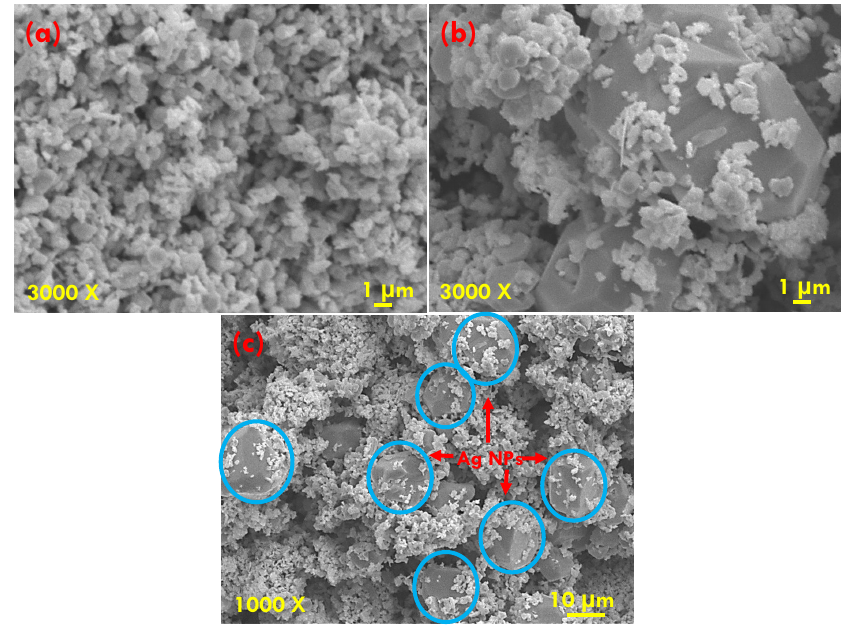
Figure 4. SEM micrographs of ( a ) MoS 2 and ( b , c ) Ag-MoS 2 composites at different magnification.